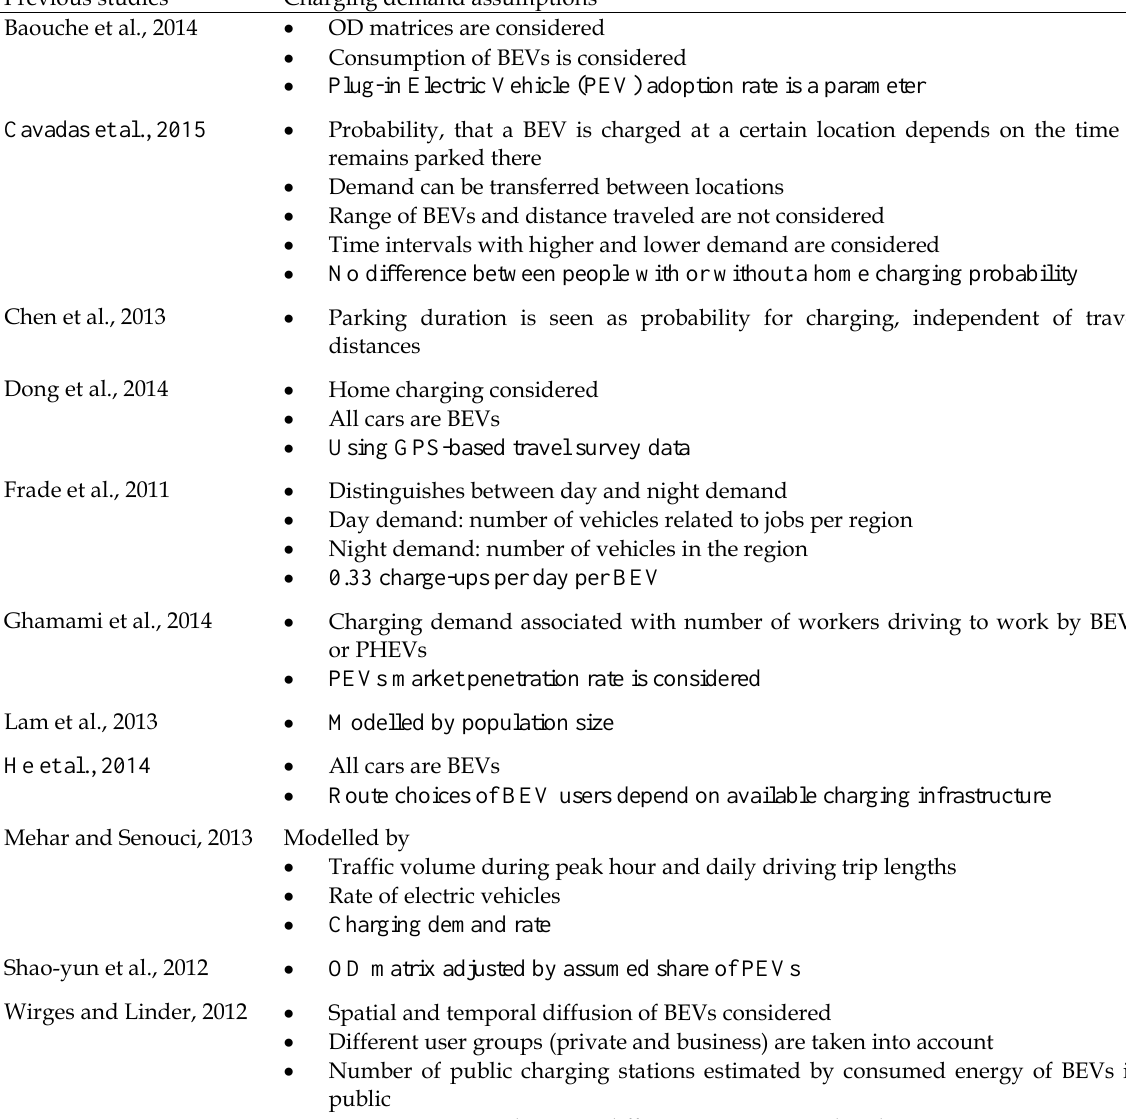
Table 1. Summary of Literature